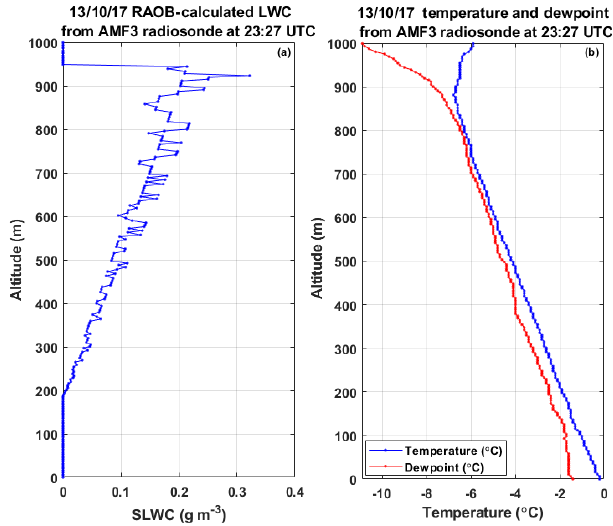
Figure 6. LWC calculated in RAOB software using Eq. (3) for 13 October 2017 23:30UTC AMF3 sounding (a) and temperature and dew point from sounding (b)